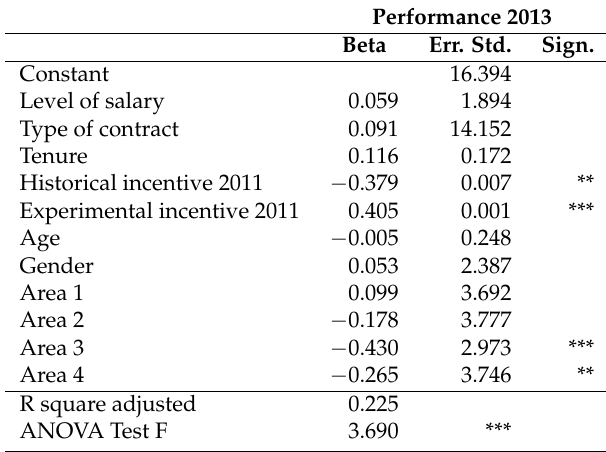
Table 10. Results of linear regressions described in Equation (6). ** Significant at the 5%. *** Significant at the